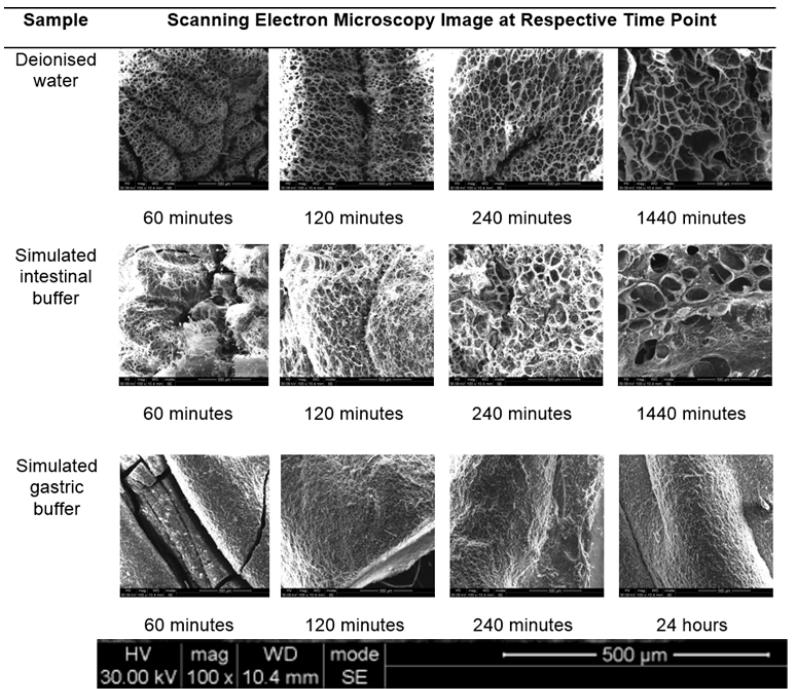
Figure 7. SEM images of the hydrogel within deionized water, simulated intestinal fluid and simulated gastric fluid at predetermined time points over a period of 24 h. All samples were analyzed at 100 times magnification with the scale bar of all samples represented in the bottom of the figure.